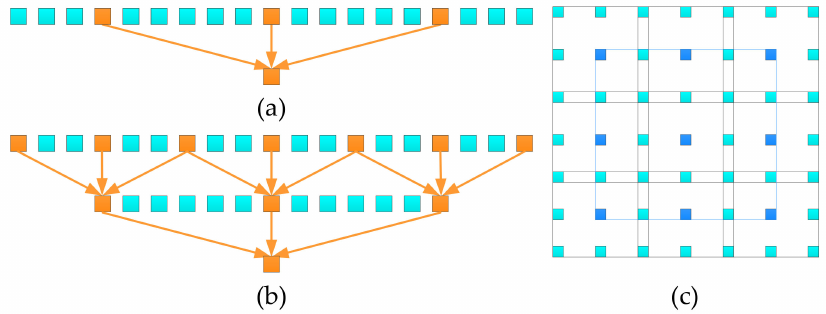
Figure 5. Schematic diagram of atrous convolution. ( a ) one dimensional atrous convolution operation ( b ) improved one-dimensional atrous convolution operation ( c ) improved two-dimensional atrous convolution